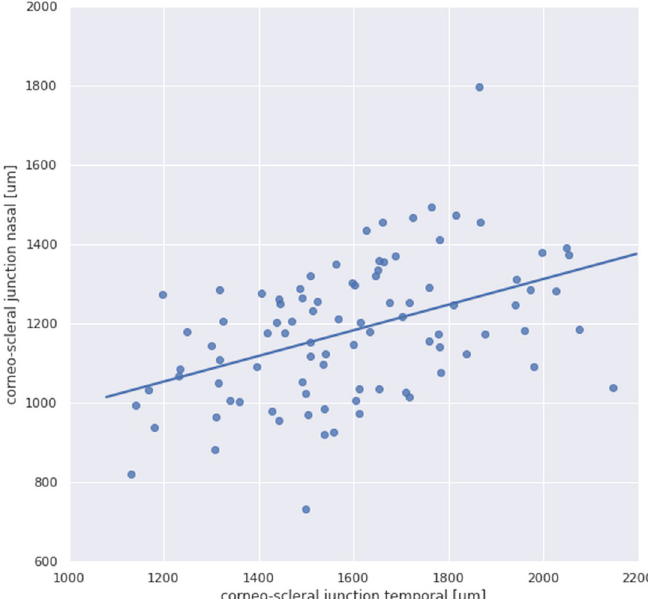
Fig 4. Correlation between corneo-scleral junction temporal width and nasal width (Spearman R = 0.46, p < .00001).